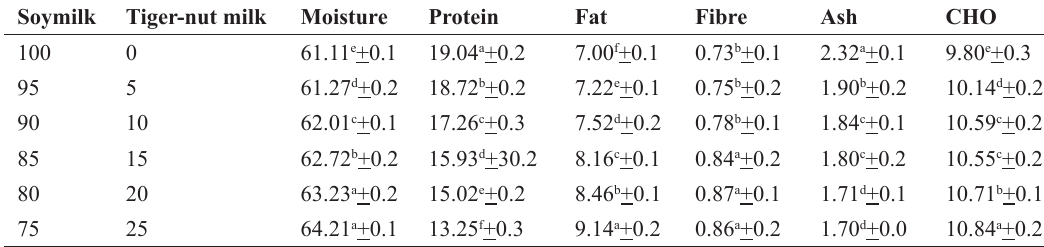
Table 2 : Proximate composition of soy/soy-tiger-nut cheese blend (%). Soymilk Tiger-nut